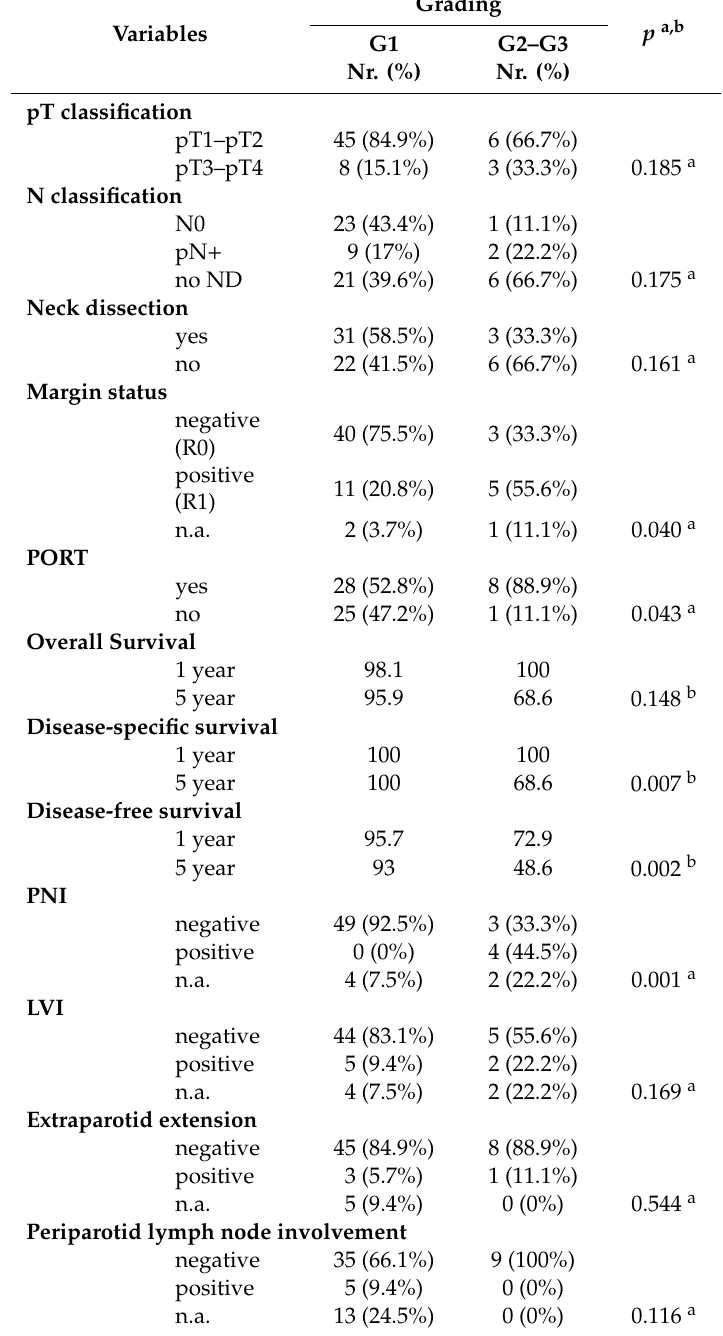
Table 5. Comparison of low grade and intermediate / high grade acinic cell carcinoma of the parotid gland.